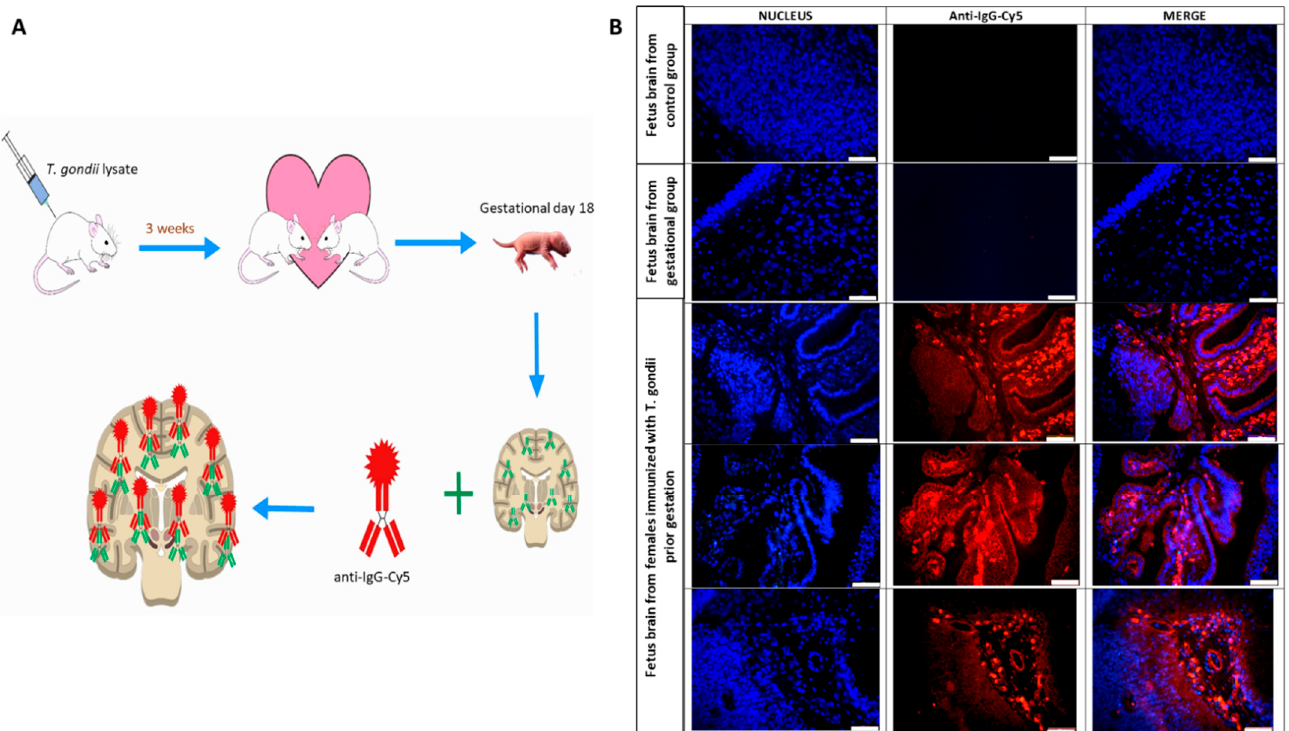
Figure 5. Anti- T. gondii IgG attached to fetal brain structures. ( A ) Diagram of the experimental design. Rats immunized prior to gestation or control, received one subcutaneous injection with T. gondii lysate or PBS, respectively, before being pregnant, for three weeks. Fetal brains from the experimental groups obtained at gestational day 18 were used to search IgG bound to brain structures. ( B ) Representative brain slice images of fetuses from the experimental groups on gestational day 18. IgGs bound to brain structures were revealed using an anti-IgG-Cy5 antibody (red). Nuclei were counterstained with DAPI (blue). Images were acquired at 40×, the bar representing 100 µm.